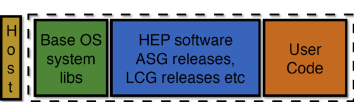
Figure 2. Docker images can be thought of as archived, executable file system snapshots, consisting of layer bundles (shown in color) corresponding to di ff erent software stacks, each one added sequentially on top of previously built